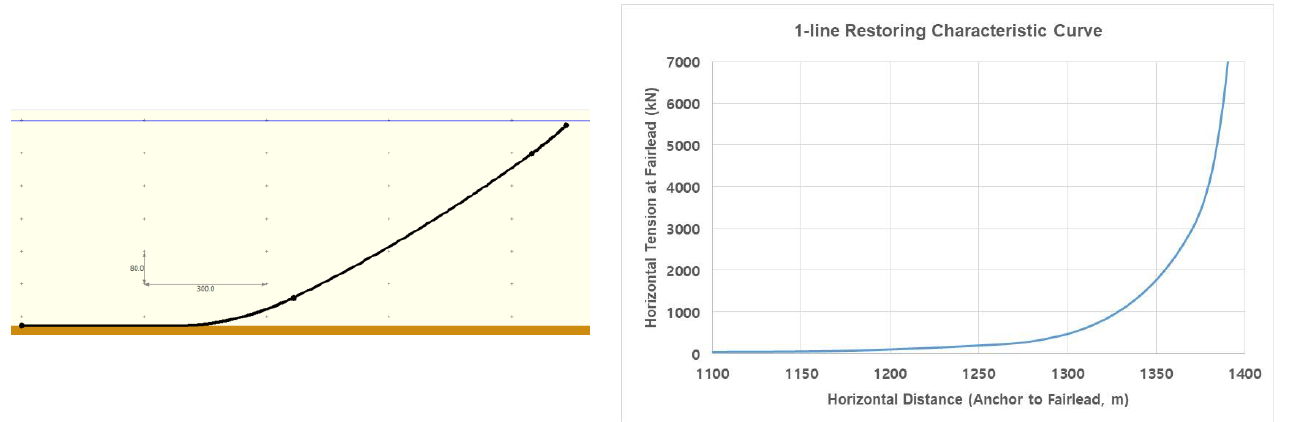
Figure 5. Initial ( top ) and optimized ( bottom ) mooring configurations for Case A.